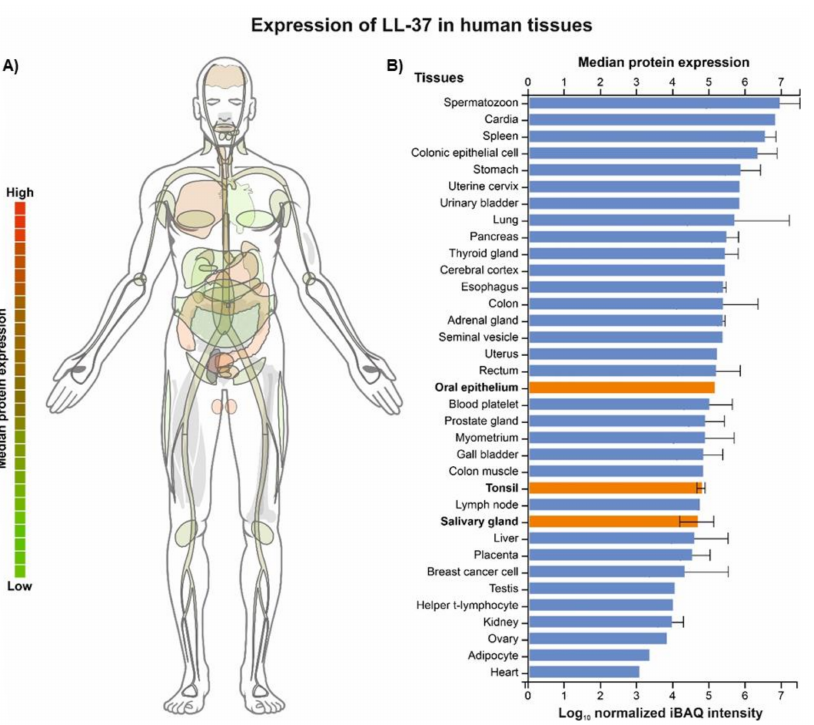
Figure 1. Expression of LL-37 in 35 human tissues, including oral epithelium, tonsils, and sali- vary glands (highlighted in orange). The data were obtained from ProteomicsDB (https://www. ProteomicsDB.org) last accessed 25 March 2022 [23] and represent mass spectrometry (MS1-level) proteome quantification; the intensity-based absolute quantification (iBAQ) value is a measure of protein abundance and corresponds to the sum of all the peptide intensities divided by the num- ber of observable peptides of a protein (panel A ). Relative abundance of CAMPs, including LL-37 (highlighted in red), present in the oral cavity (whole organism—integrated; LL-37 is highlighted in red). The data were obtained from PAXdb (Protein Abundance Database; https://pax-db.org/) last accessed 25 March 2022 ) [24] and are based on a mass-spectrometry-based study of the human proteome by Wilhelm et al. (2014) [25]; parts-per-million (ppm) values represent the abundance of each protein with reference to the entire expressed proteome, i.e., each protein entity is enumerated relative to all other protein molecules in the sample (panel B